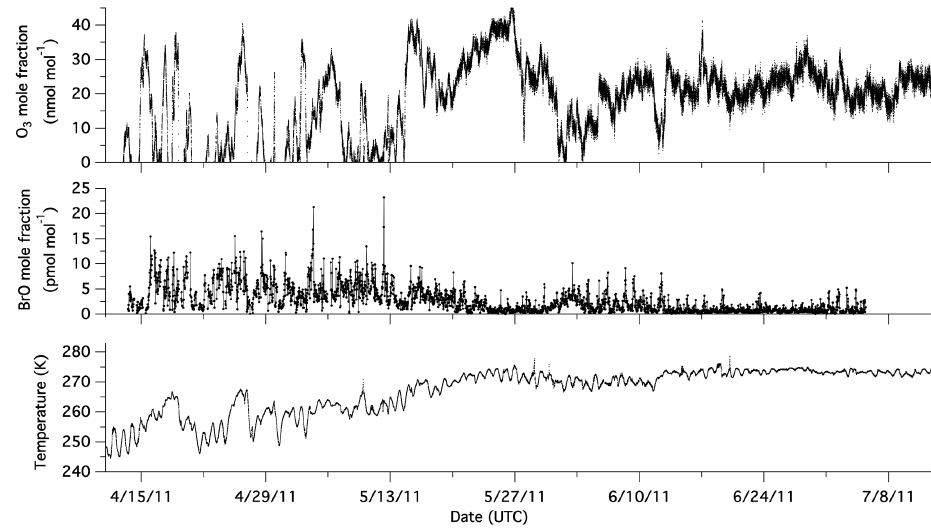
Figure 2. Example time series of O 3 , BrO, and temperature from O-Buoy2 during its deployment in the Beaufort